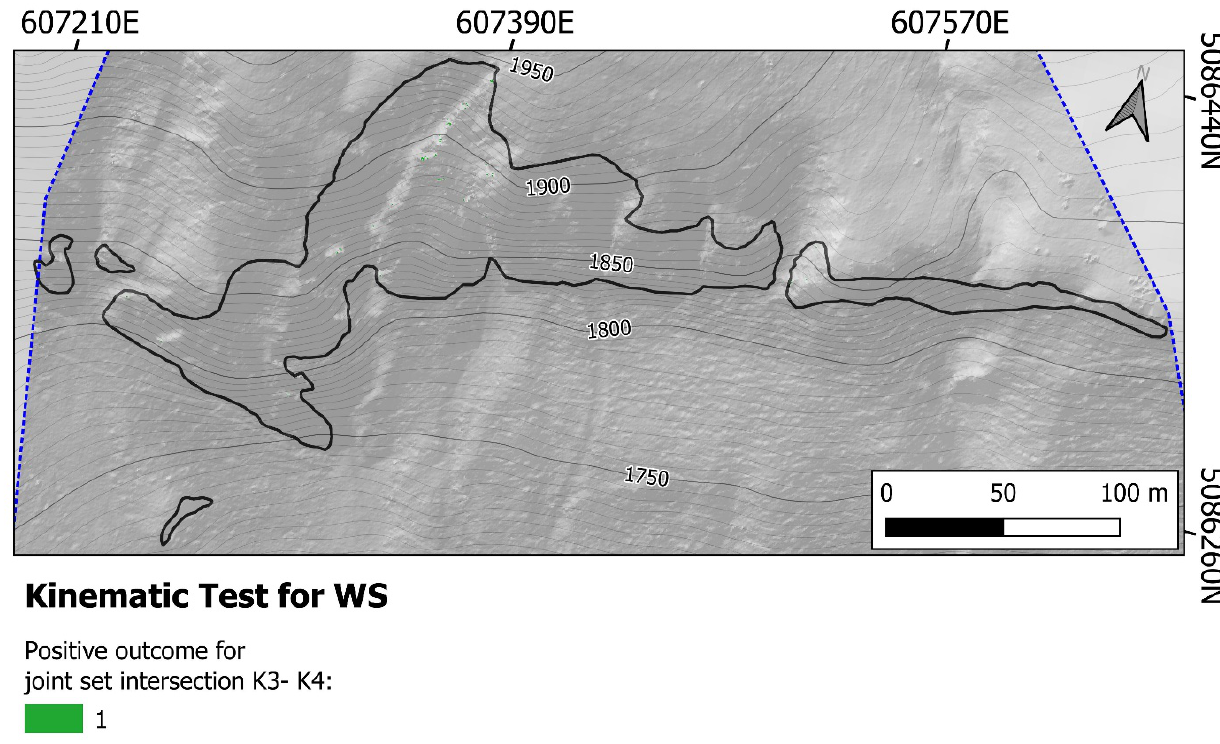
Figure A9. Image of the partial output file showing the kinematic test for WS performed considering only the intersection between joint set K2 and K4.